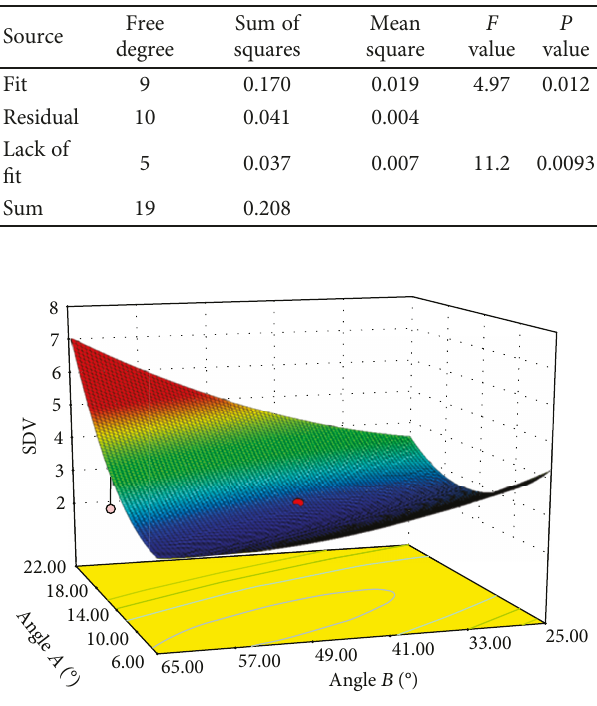
Figure 6: Response surface plots of the SDV as a function of angles A and B .